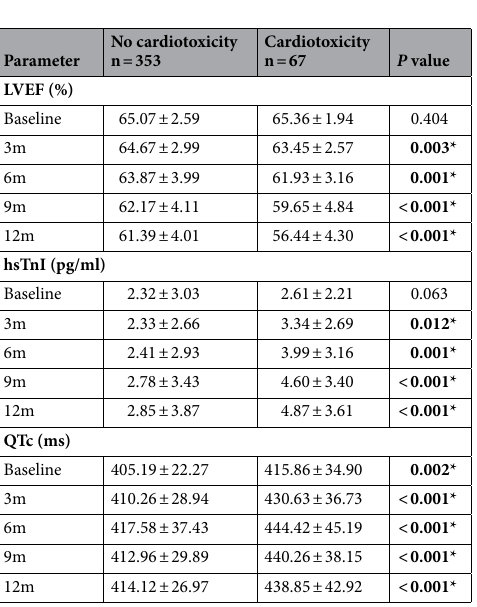
Table 3. Comparison of LVEF, hs-TnI and QTc at each time point between non-cardiotoxicity group and cardiotoxicity group. Significant values are in [bold]. m month. * P <